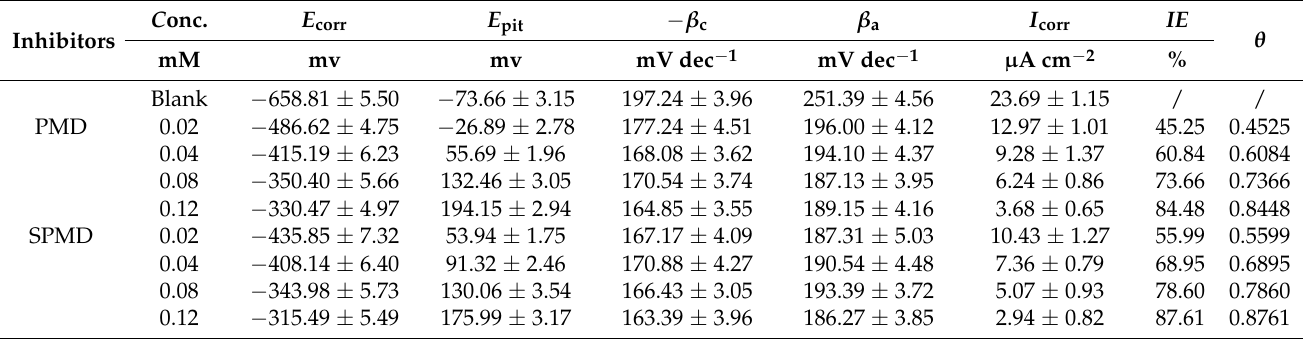
Figure 2. Potentiodynamic polarization for the corrosion of HRB400 reinforced steel in SCP solution with different concentrations of PMD ( a ) and SPMD ( b ) at 25 °C. Table 1. PDP parameters for HRB400 reinforced steel in SCP